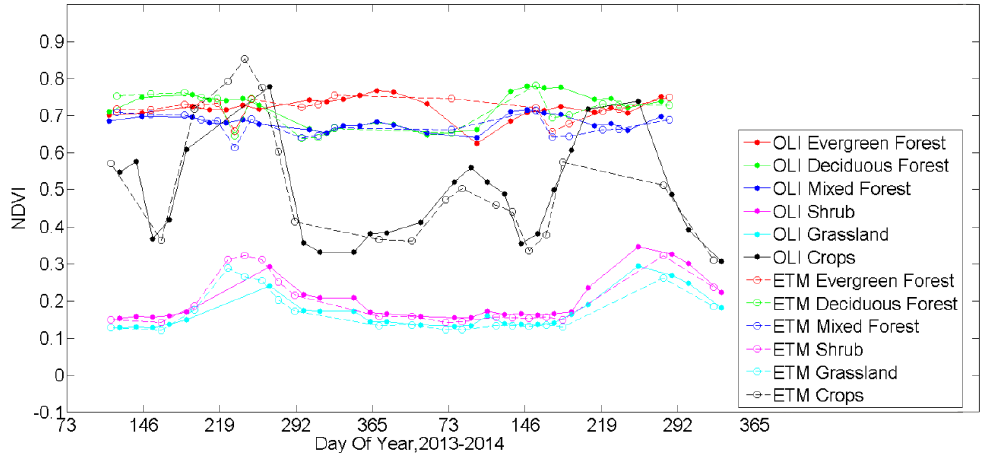
Figure 6. NDVI time series profiles calculated by Landsat OLI (solid lines with circles) and ETM+ (dash lines with hollow circles) data for the six vegetation classes used in this study in different colors. Each profile was averaged from 1000 samples extracted from each